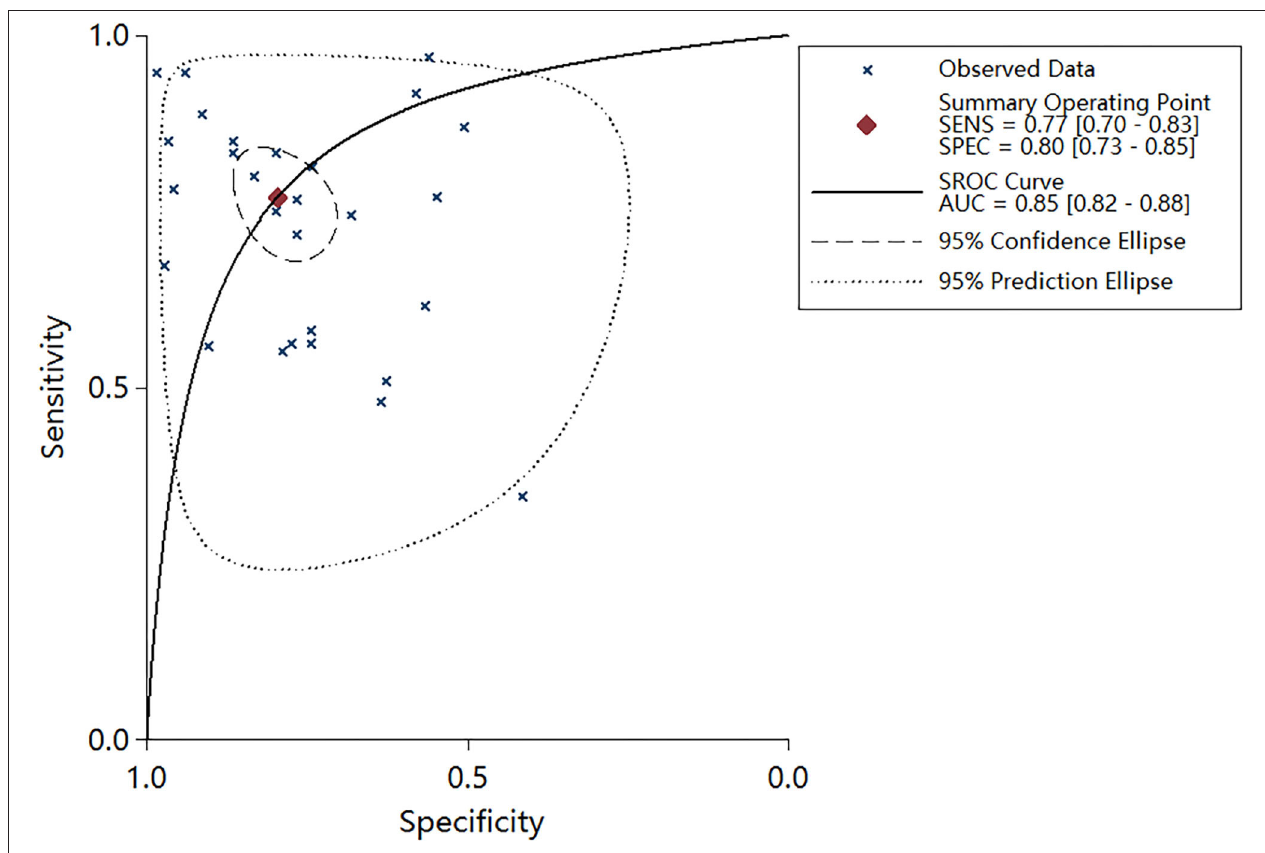
FIGURE 4 | Summary receiver operator characteristic (SROC) curve with area under curve (AUC) based on miRNAs.